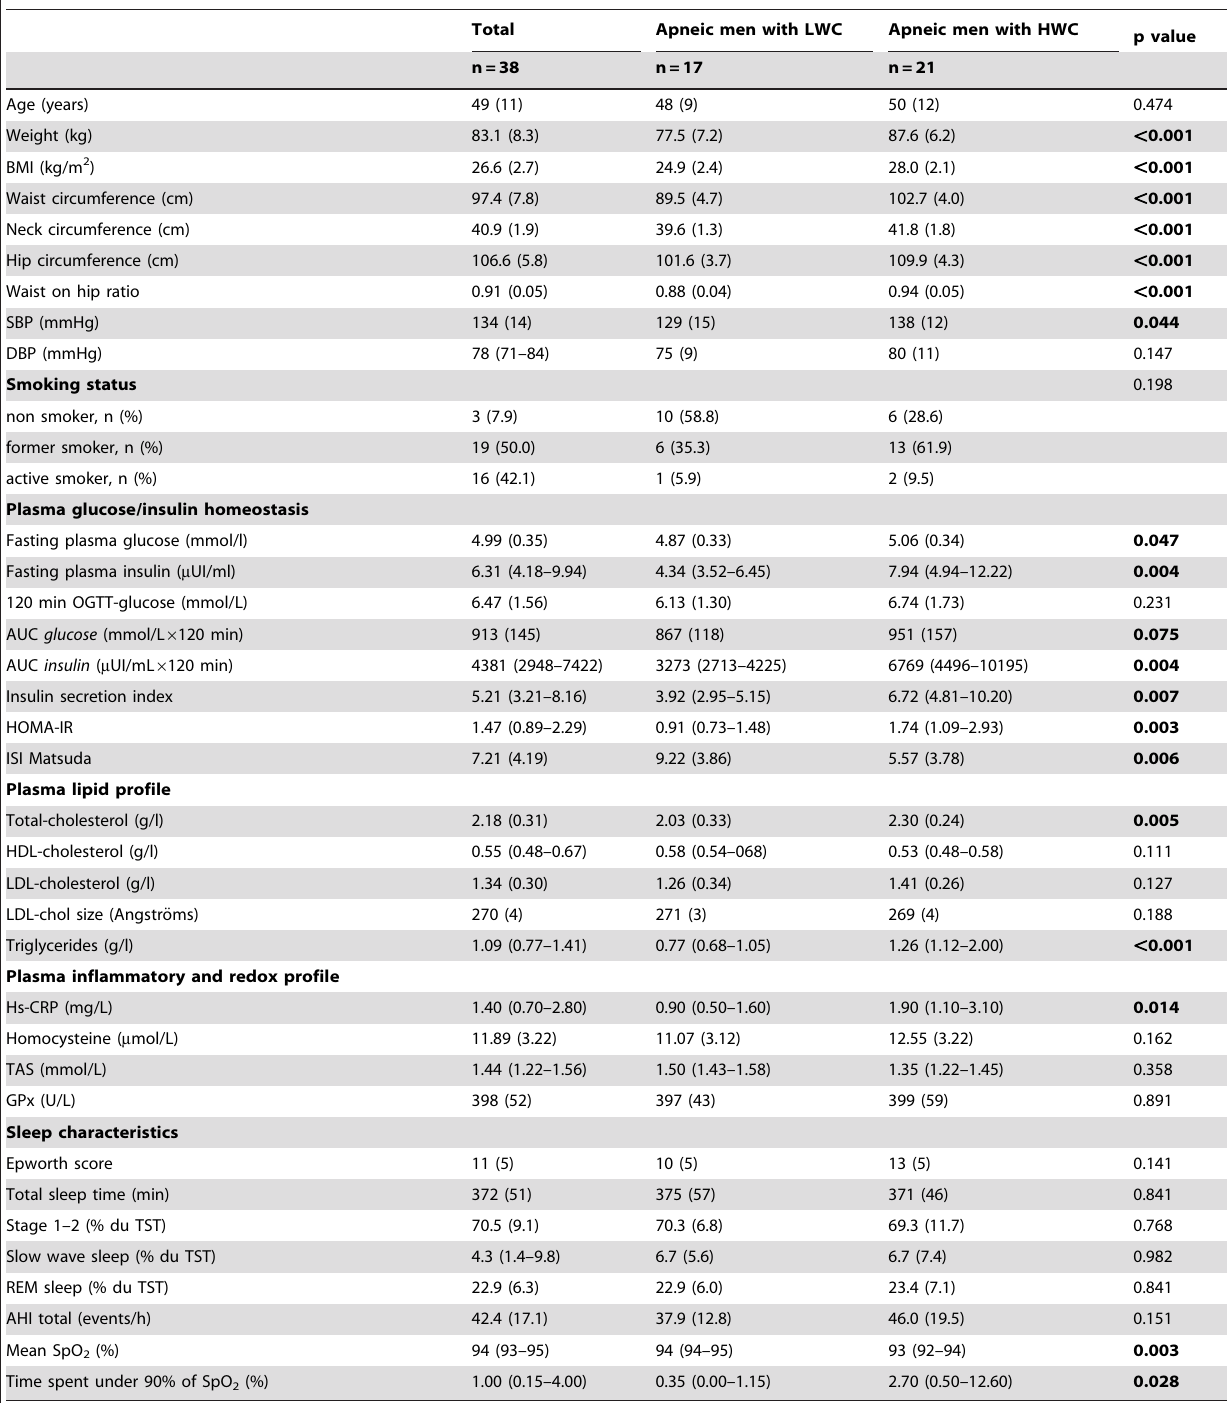
Abbreviations: HWC: High waist circumference, LWC: Low waist circumference, BMI: body mass index, SBP: Sleep blood pressure, DBP: diastolic blood pressure, OGTT: oral glucose tolerance test, AUC: area under the curve, ISI: insulin sensitivity index, HOMA-IR: HOMA-resistance index, Hs-CRP: high sensitive CRP, TAS: total antioxidant status, GPx: plasma glutathione peroxidase, REM: rapid eyes movement, AHI: apnea-hypopnea index.